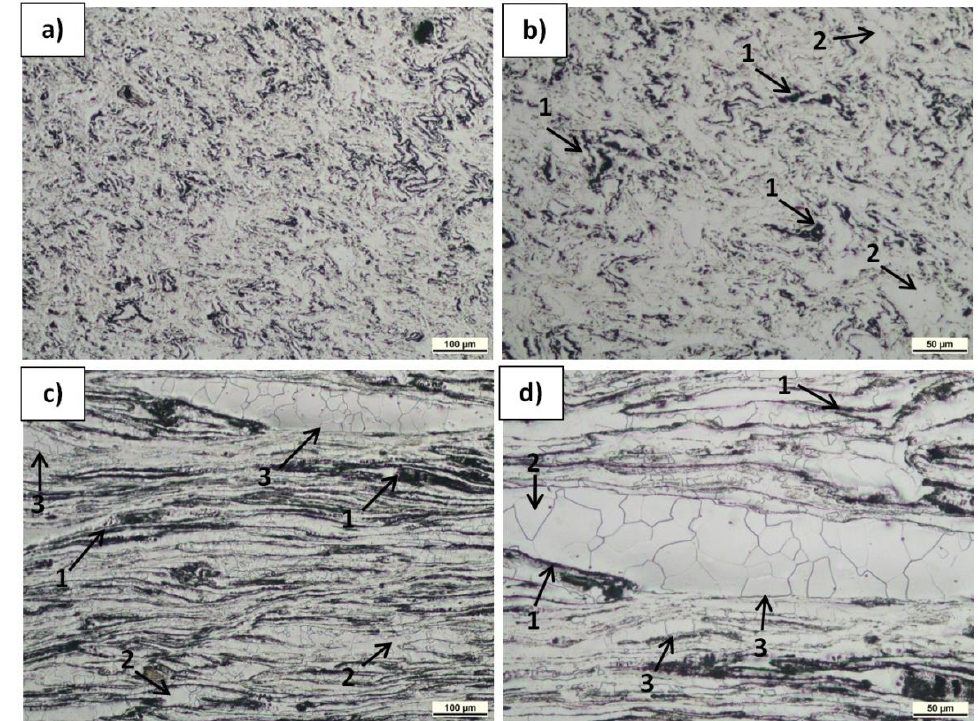
Figure 6. LM micrographs of etched transverse ( a,b ) and longitudinal ( c,d ) sections of Mg(P) rod KOBO-extruded: 1 — MgO bands, 2 —α -Mg grains, 3 —α -Mg grains of shape determined by MgO bands position.